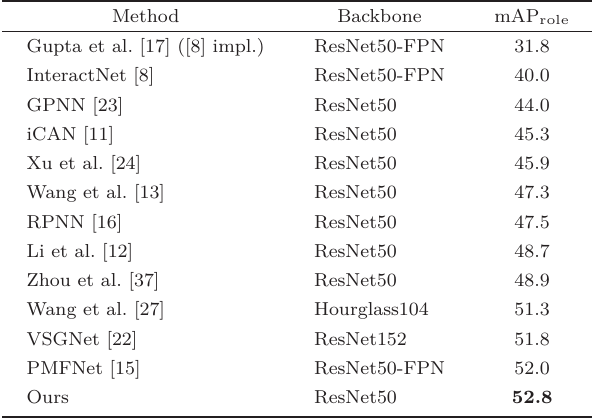
Table 1 Comparison with state-of-the-art methods on the V-COCO [17] test set